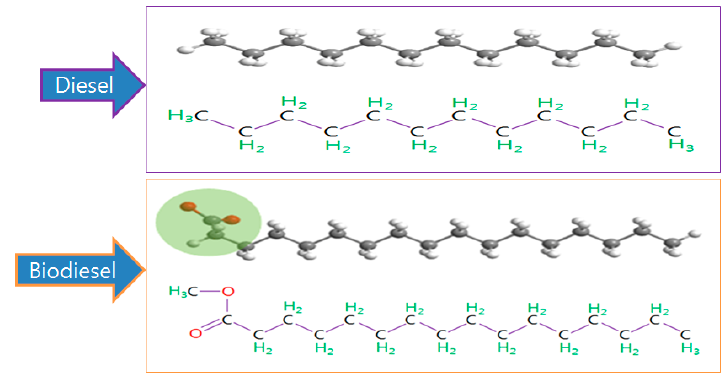
Figure 8. Molecular structure diagram of diesel and biodiesel.